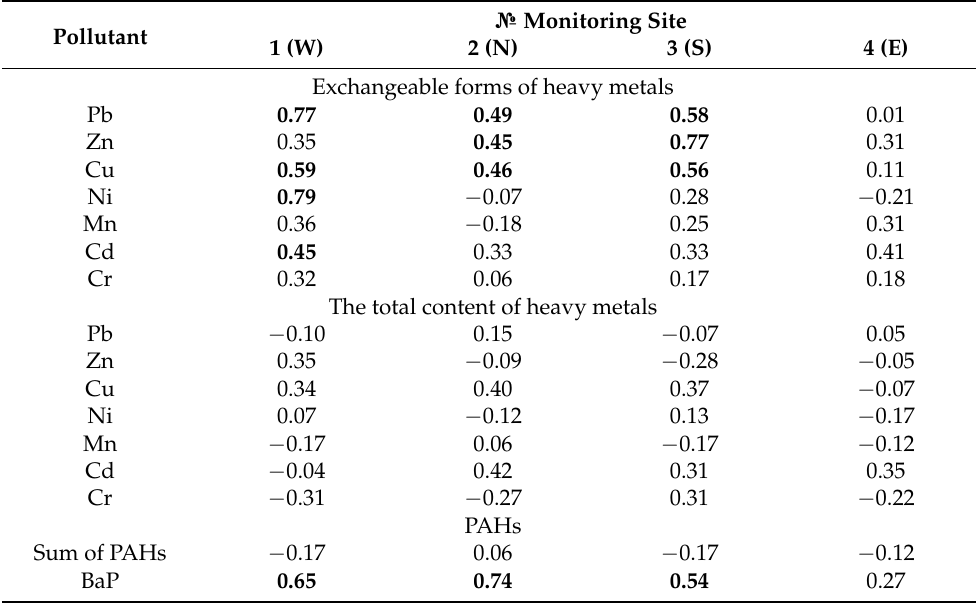
Table 2. Correlation between the content of pollutants in soil and time.